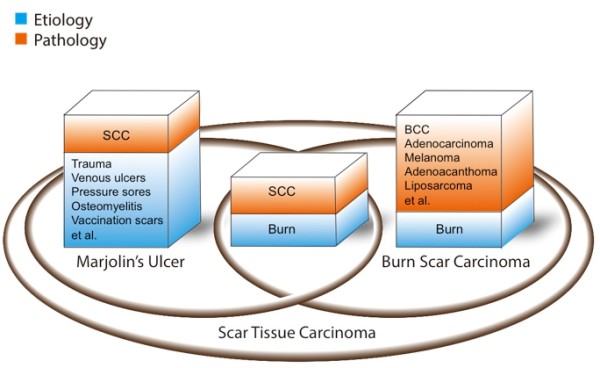
Comparison of the concepts of MU, burn scar carcinoma, and scar tissue carcinoma. The intersection between MU and burn scar carcinoma represents the etiology and pathological outcome in common. SCC = squamous cell carcinoma; BCC = basal cell carcinoma.